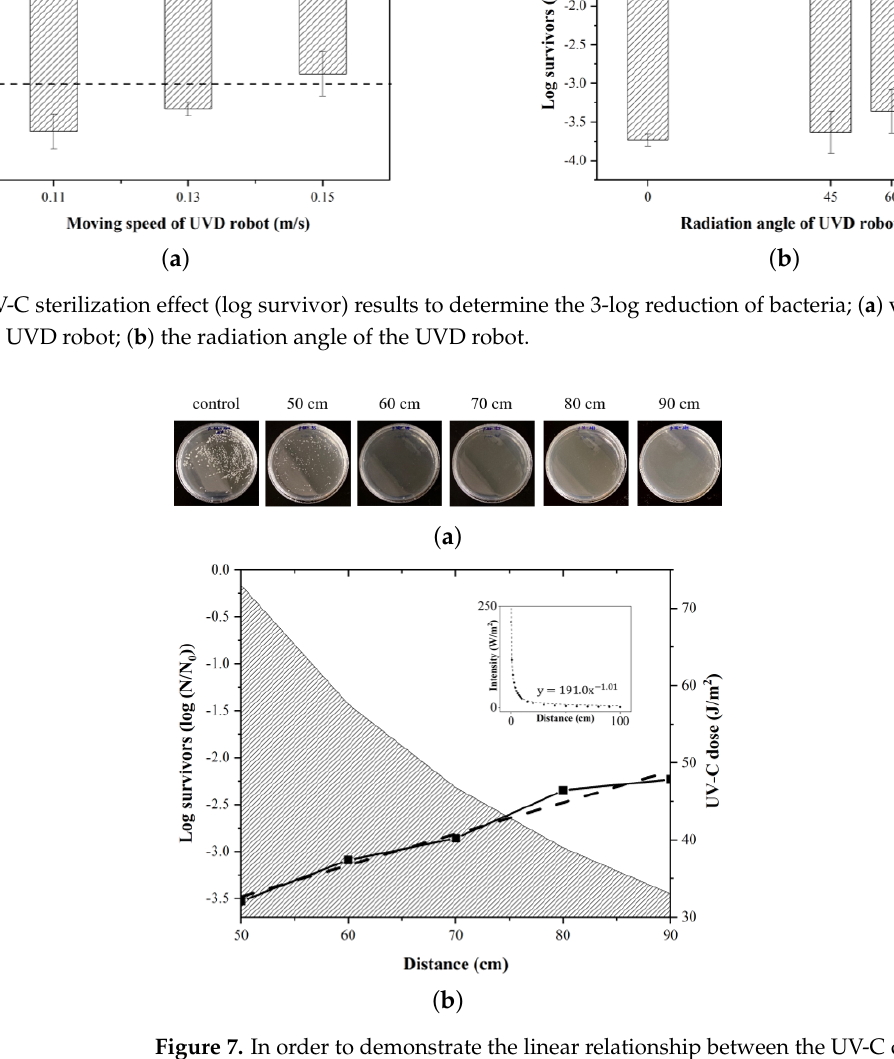
Figure 7. In order to demonstrate the linear relationship between the UV-C dose and the disinfection effect (log survivors of bacteria), which is inversely proportional to the distance between the UV-C source and the sample, the sterilization effects of P. aeruginosa at varying distances (50, 60, 70, 80, and 90 cm) were estimated with the equivalent disinfection experiment, described as Section 2.4 with stationary UV-C light condition. ( a ) Bacterial plates; ( b ) disinfection effect (log survivors) where the distance between the UV-C light and the bacteria plates varies with the corresponding UV-C dose are shown. The inset figure shows the inverse relationship between the distance and the UV-C